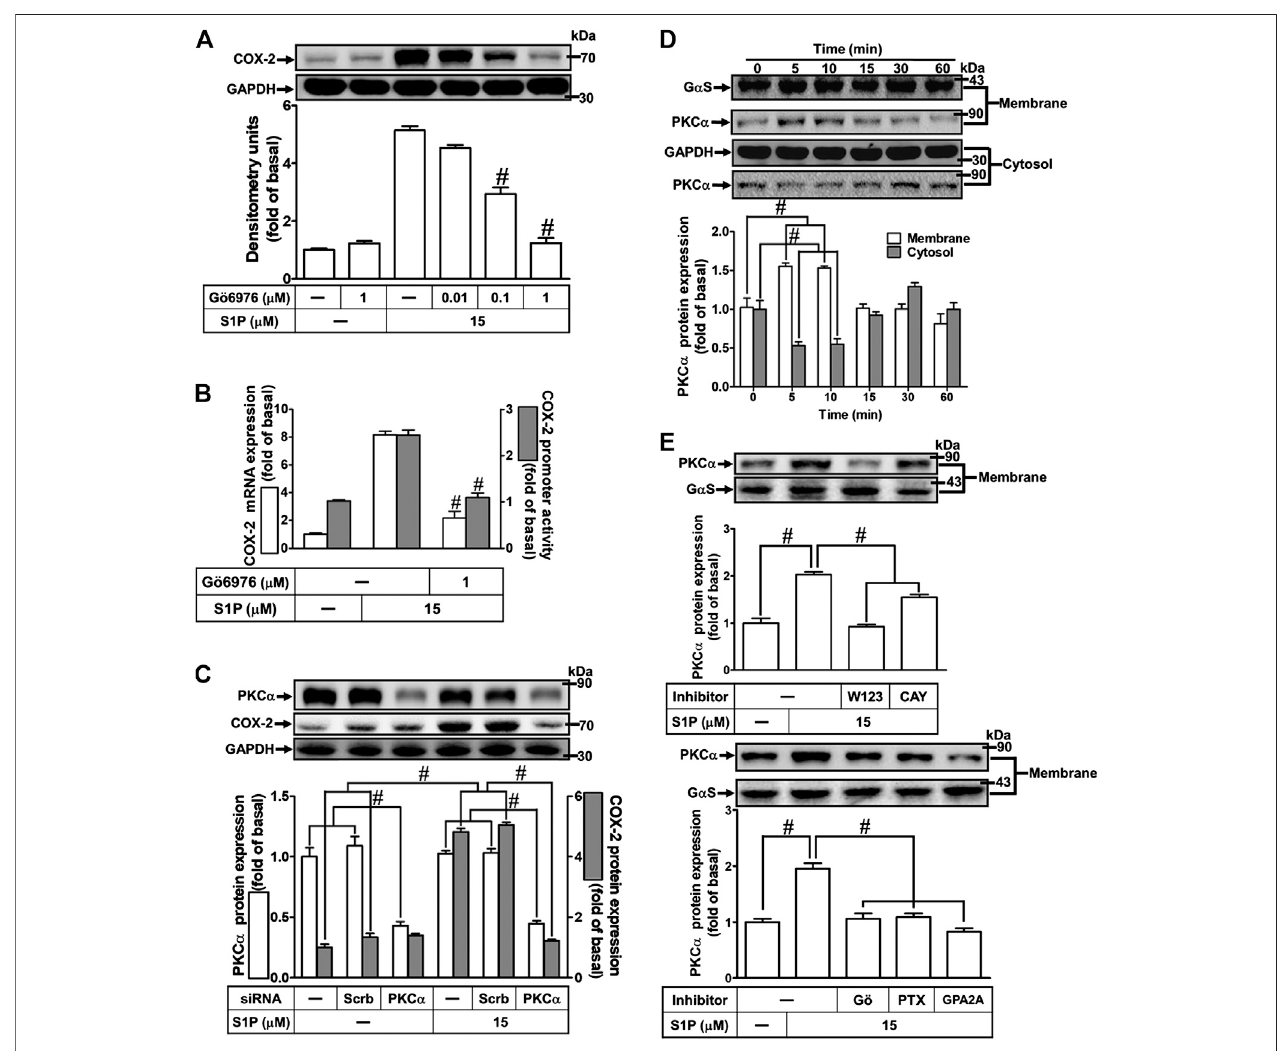
FIGURE 4 | PKC α mediates S1P-induced COX-2 expression. (A) Cells were pretreated with Gö6976 for 1 h and then incubated with 15 μ M S1P for 8 h. (B) Cells weretransfectedwithoutorwithCOX-2promoter-luciferasereportergene,pretreatedwithoutorwithGö6976(1 μ M)for1 h,andthenincubatedwith15 μ MS1Pfor4 h (mRNA) or1 h(promoter).Westernblot,realtime-PCR, andpromoterassaywereperformedtodetermine thelevels ofCOX-2protein, mRNAexpression, andpromoter activity,respectively. (C) PriortoexposurewithS1Pfor8 h,cellsweretransfectedwithsiRNAofscrambledorPKC α . (D) CellswereincubatedwithS1P(15 μ M)for the indicated time intervals. (E) Cells were incubated with S1P (15 μ M) for 5 min in the absence or presence of Gö6976 (1 μ M), W123 (10 μ M), CAY (10 μ M), GPA2A (10 μ M), or PTX (100 ng/ml) for 1 h. The membrane and cytosol fractions were prepared and analyzed by Western blot. Data are expressed as mean ± SEM of three individual experiments (n (cid:2) 3). # p < 0.05, as compared with the cells treated with S1P